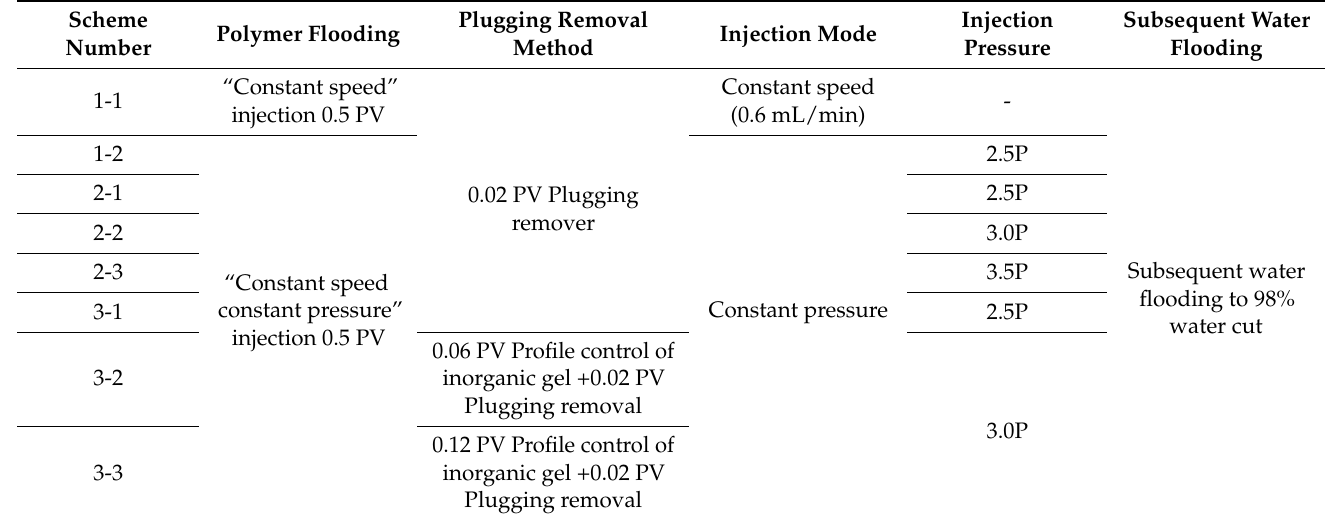
Table 13. Experimental programme